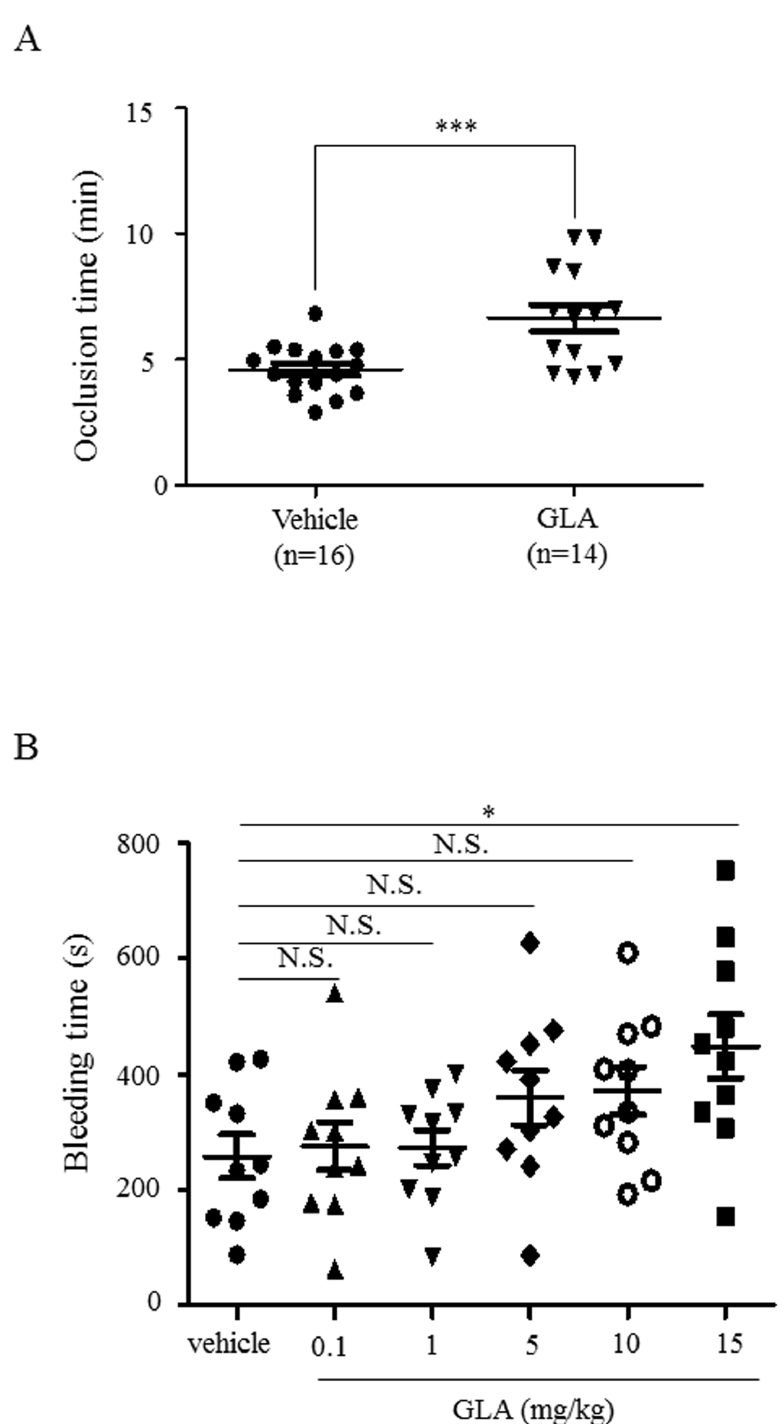
Figure 8. GLA inhibits thrombus formation in vivo, but did not extend the tail bleeding time in mice. GLA was given at a single bolus i.p injection with solvent as a vehicle control. (A) FeCl3-induced carotid artery injury mouse model was performed and the time to occlusion was measured using Visual Sonics View 2100 and analysed using Student T test (mean ± standard error, P < 0.001). (B) The distal 5 mm of the tail of anesthetized mice was transected and the time to bleeding cessation was recorded. Data were analyzed using GraphPad Prism 5.0 software with the Bonferroni post test for multiple groups (mean ± standard error, n=10 for each group) *P < 0.05. N.S., not significant. doi: 10.1371/journal.pone.0085120.g008 PLOS ONE |